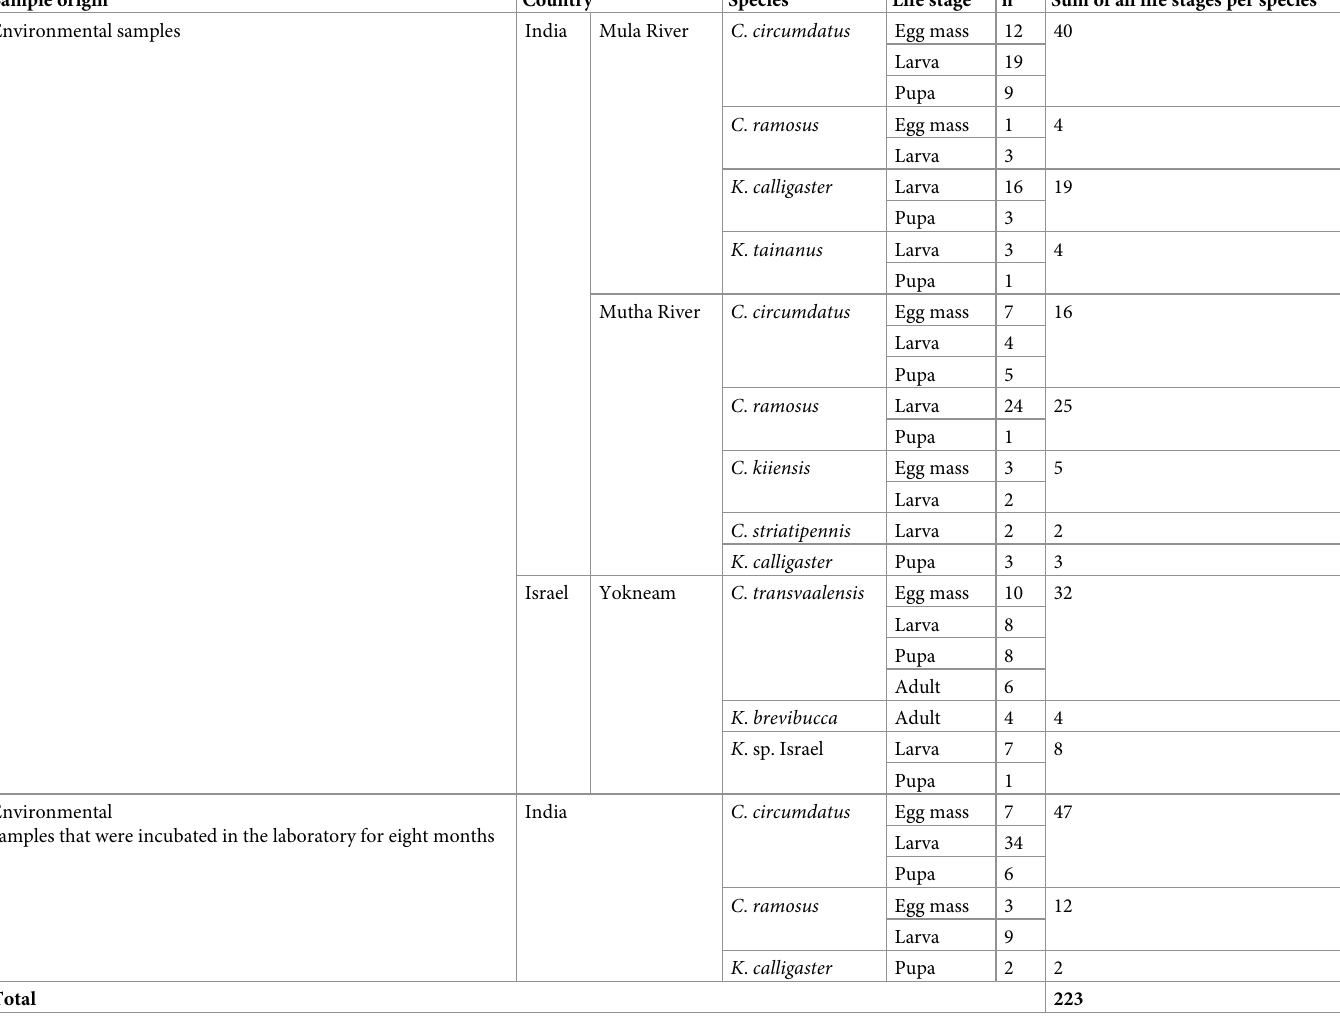
Table 1. The distribution of chironomid species identified from all the investigated sampling sites. Chironomids were randomly sampled at different life stages. Adults emerged from pupae when brought to the laboratory after sampling. C ., Chironomus; K ., Kiefferulus . Sample